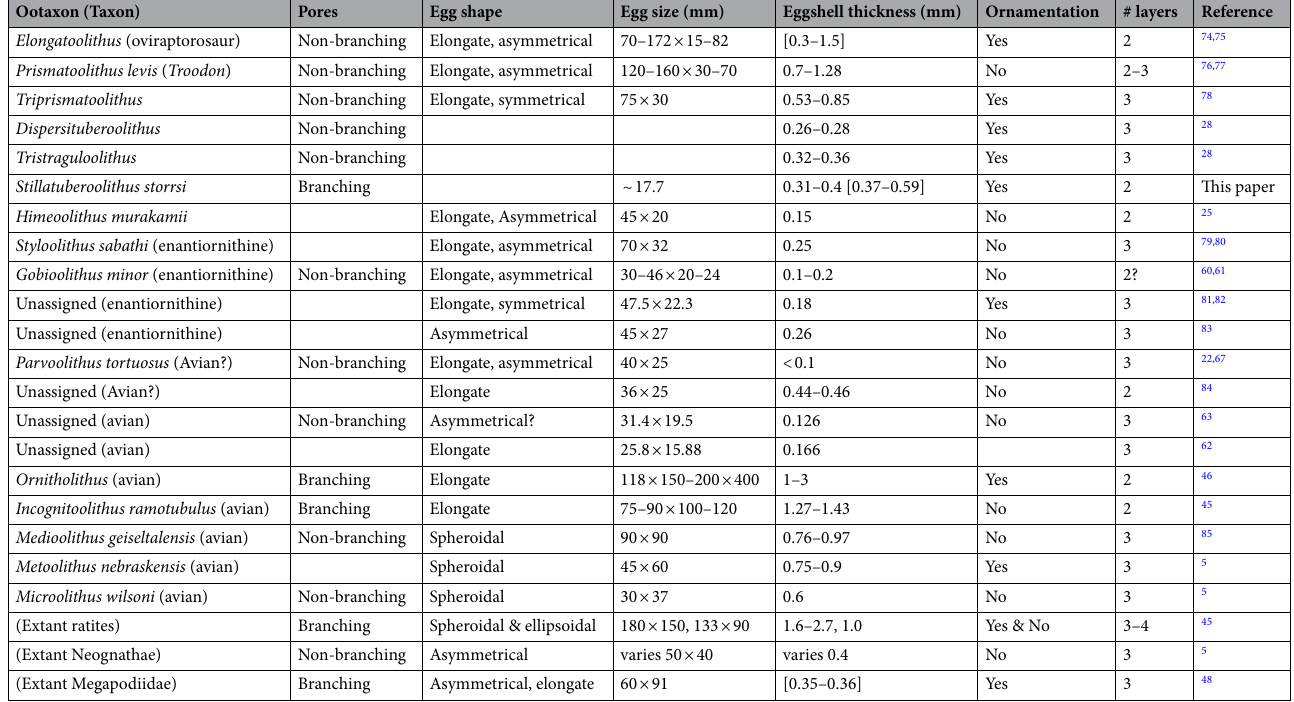
Table 2. Mosaic of egg features that characterize Cretaceous-Cenozoic avian and non-avian theropod eggs. For extant ratites, egg size and eggshell thickness are given for Struthio and Dromaius . Extant megapode ranges are from Alectura lathami . For extant Neognathae, the egg size and shell thickness of Gallus gallus domesticus is provided for